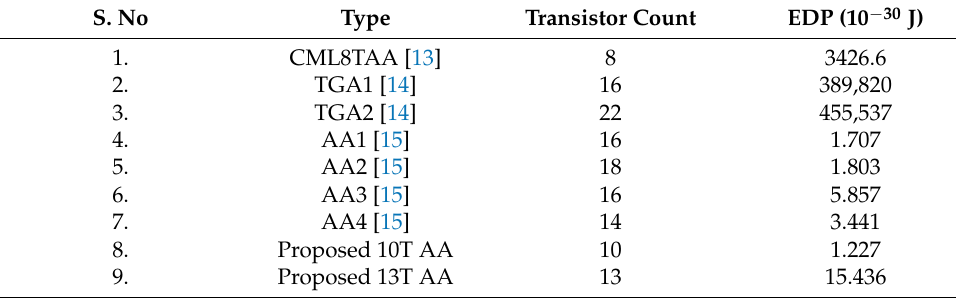
Table 6. Comparison of AA with proposed 10T AA and 13T